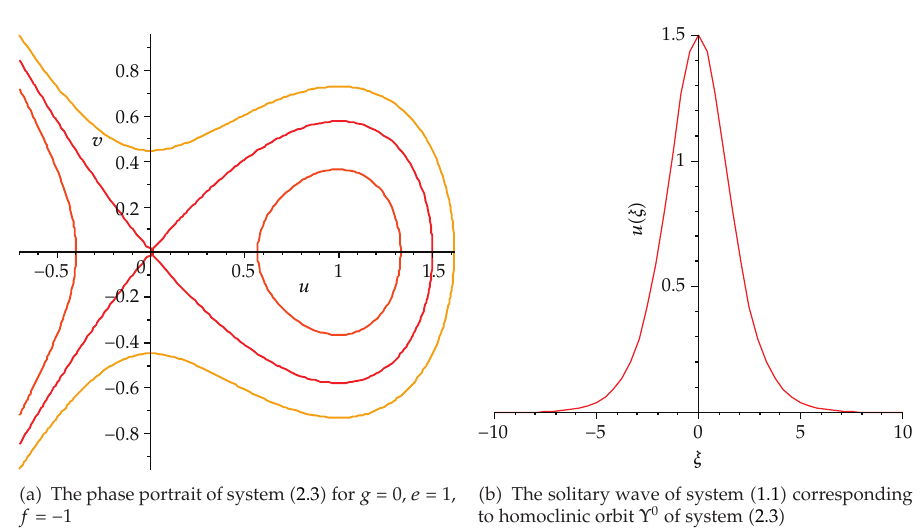
Figure 1: Homoclinic orbit and solitary